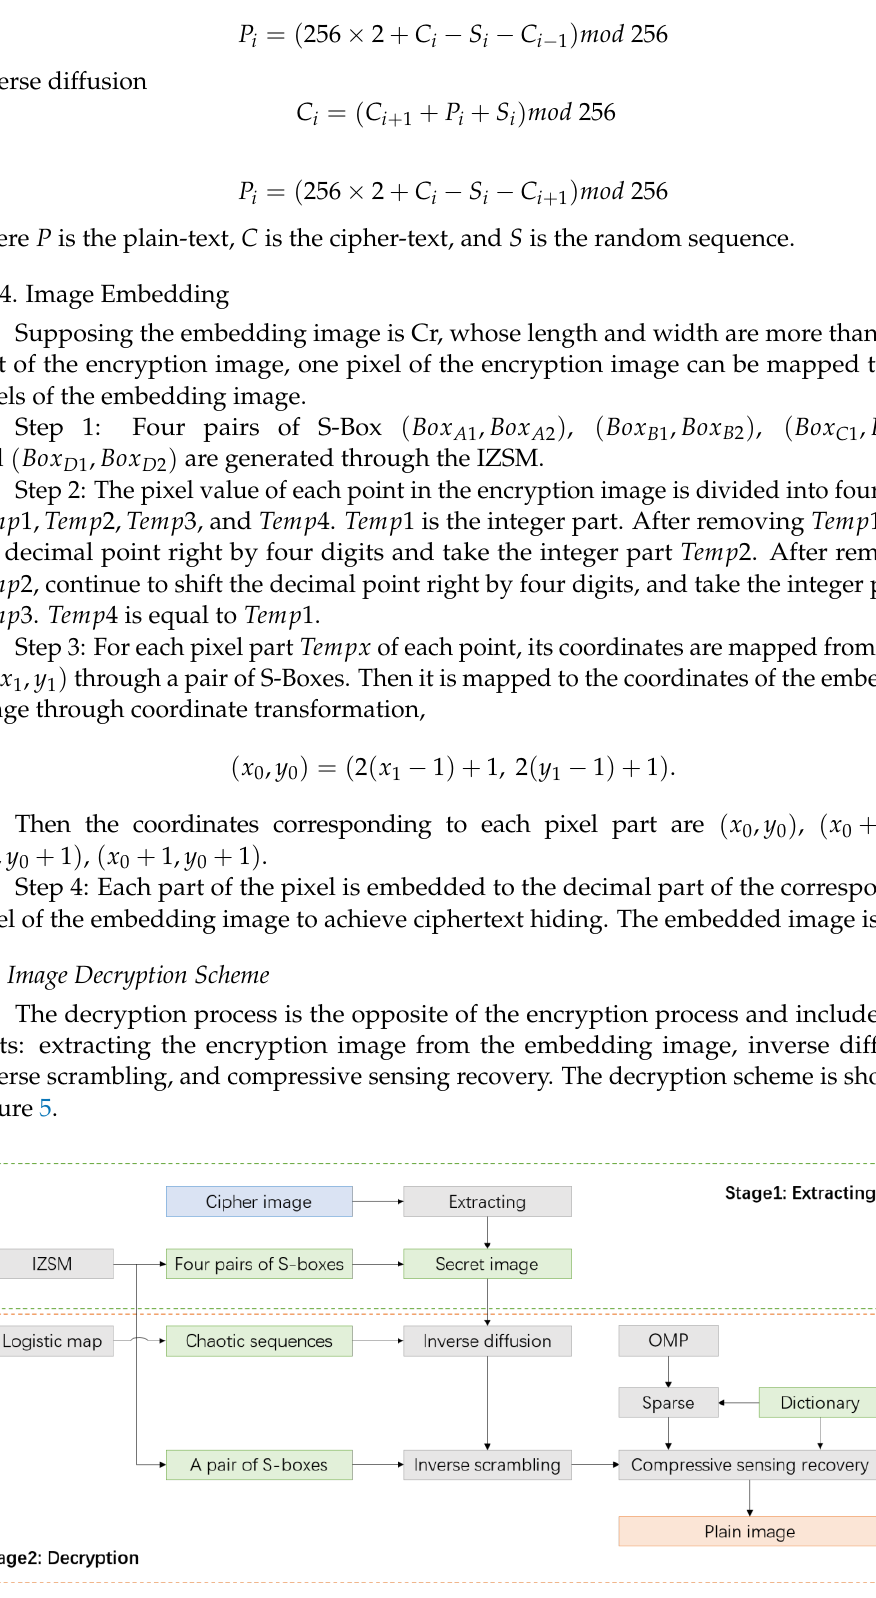
Figure 5. The scheme for image